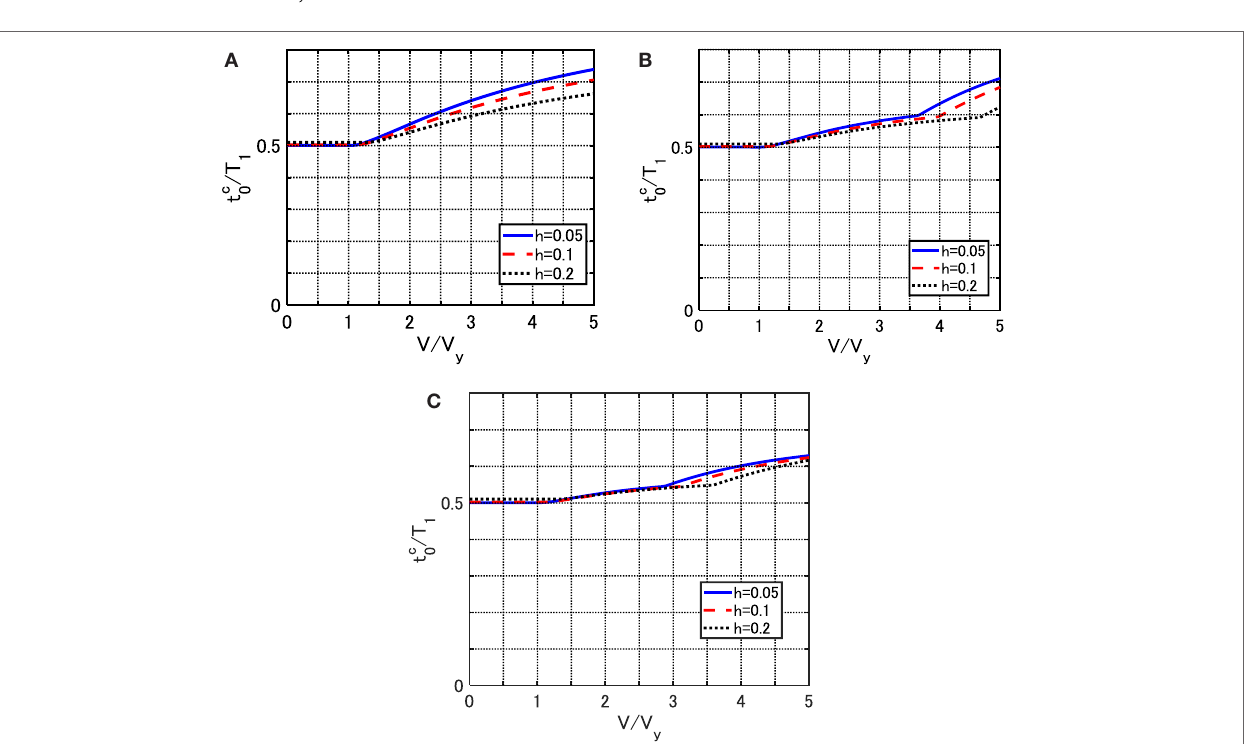
Frontiers in Built Environment |